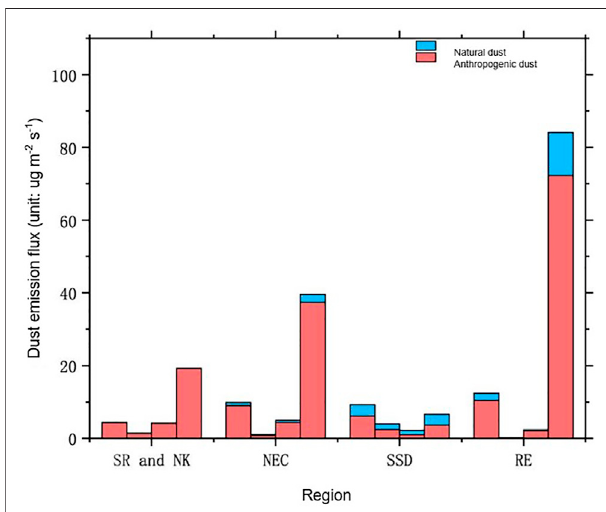
FIGURE 9 | Scatter plot of the linear correlation between PM 2.5 observations (standardized) and simulated dust emission fl uxes (standardized). RE represents Russia (46 – 56 ° N, 5 – 50 ° E); WI and NWI represent western and northwestern India (15 – 37 ° N and 68 – 79 ° E); NEC represents northeastern China (40 – 50 ° N, 110 – 125 ° E); CUS represents central United States (35 – 48 ° N, 100 – 122 ° W).